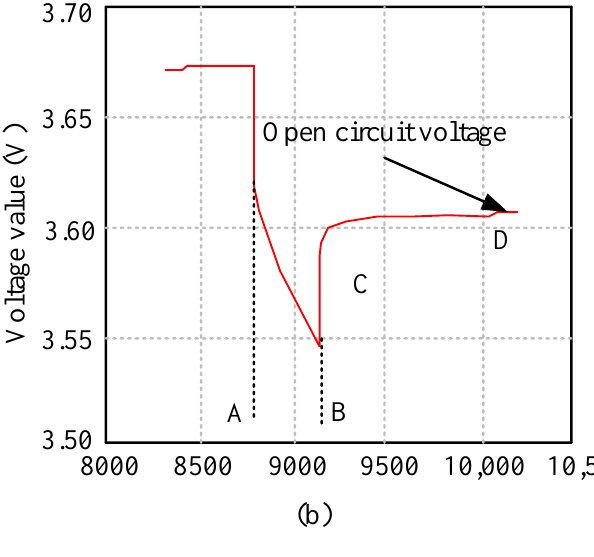
Figure 2. Model and sampling.